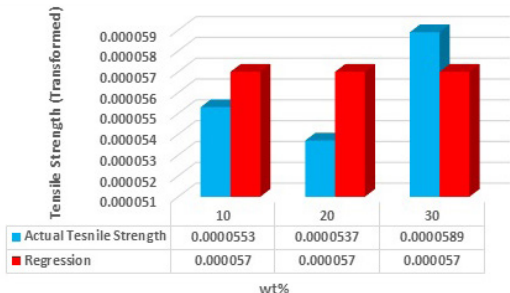
Figure 8. A comparison between the regression equation and the actual value of the tensile strength of treated hemp-PP composite.